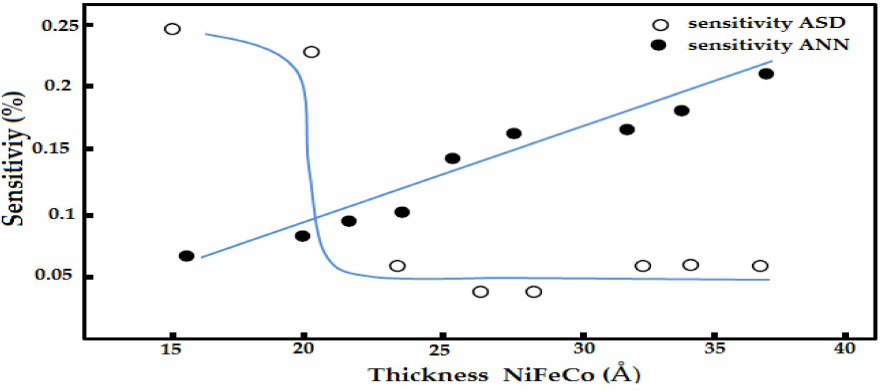
Figure 15. GMR sensitivity in as-deposited (ASD) and annealed (ANN) states as a function of the NiFeCo layer thickness by Hossain et al. [50].